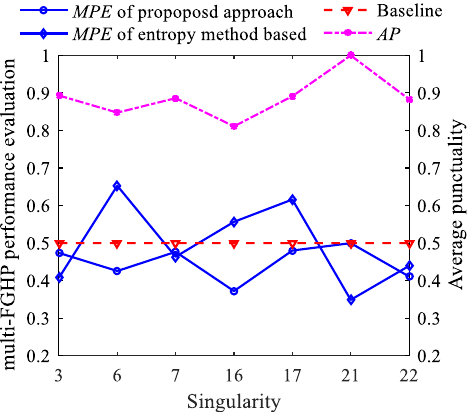
Figure 9. Illustration of performance evaluation for singularity by different approaches.